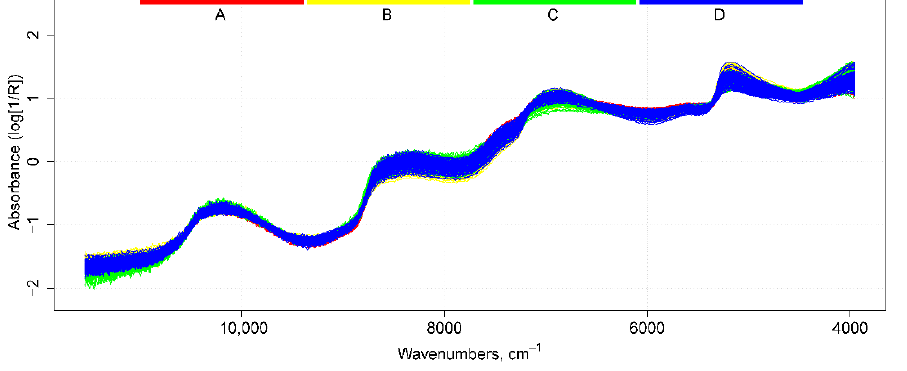
Figure 3. SNV pre-treated spectra of the four classes.